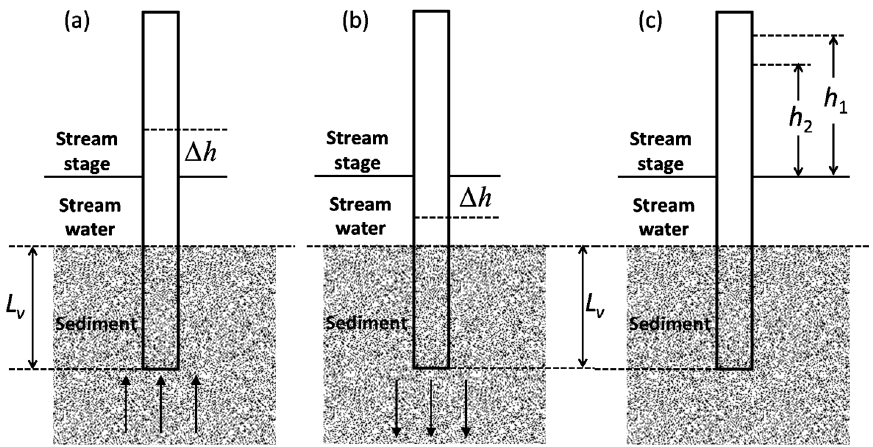
Figure 2. Measurement setup at each test point: ( a ) measurement of VHG showing upwelling with upward arrows; ( b ) measurement of VHG showing downwelling with downward arrows; and ( c ) measurement of K v .